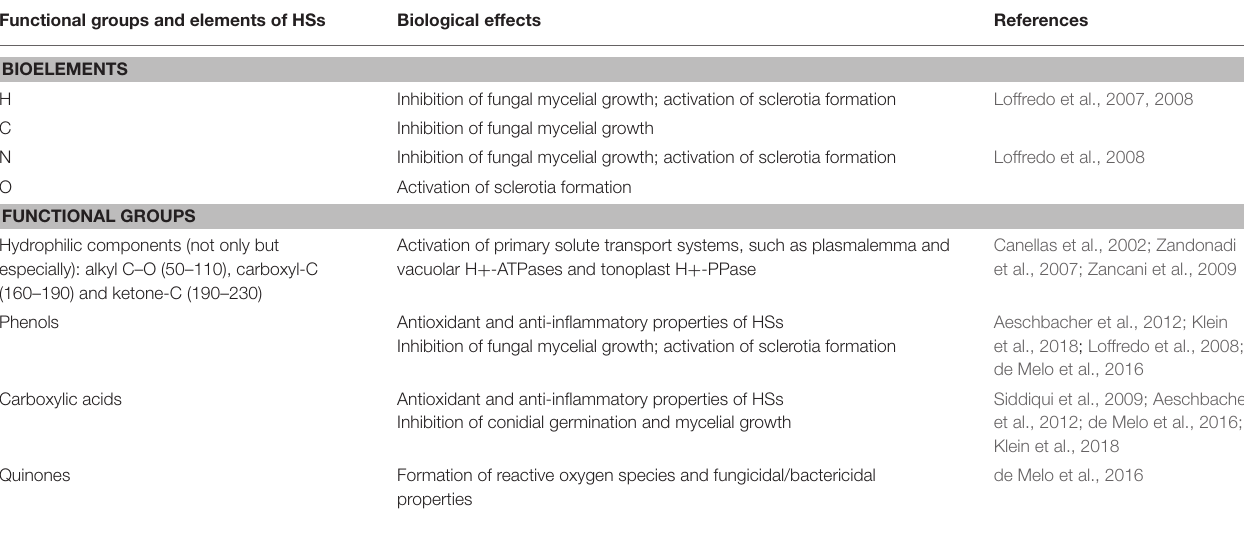
TABLE 2 | Functional groups and elements of HPs and effects on biological characteristics of